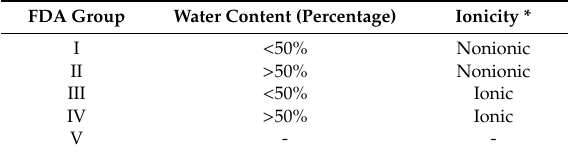
Table 2. Food and Drug Administration (FDA) classification of soft contact lens